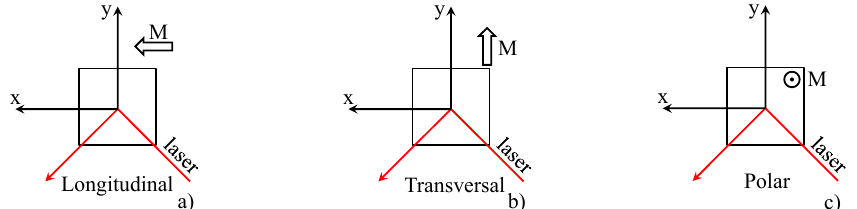
Figure 3. MBN sensor positioning.